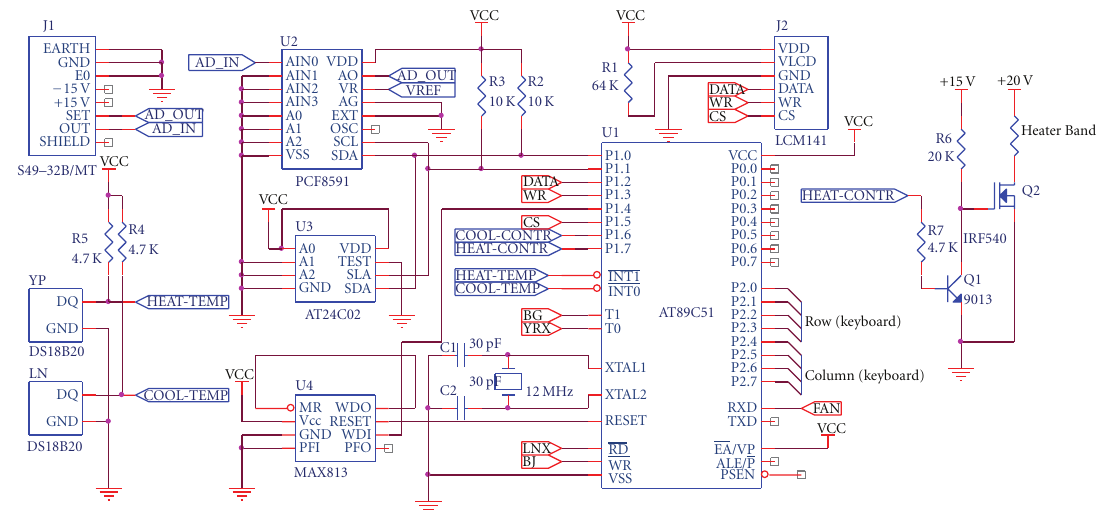
Figure 3: Control circuit diagram of GP-HS-LPME